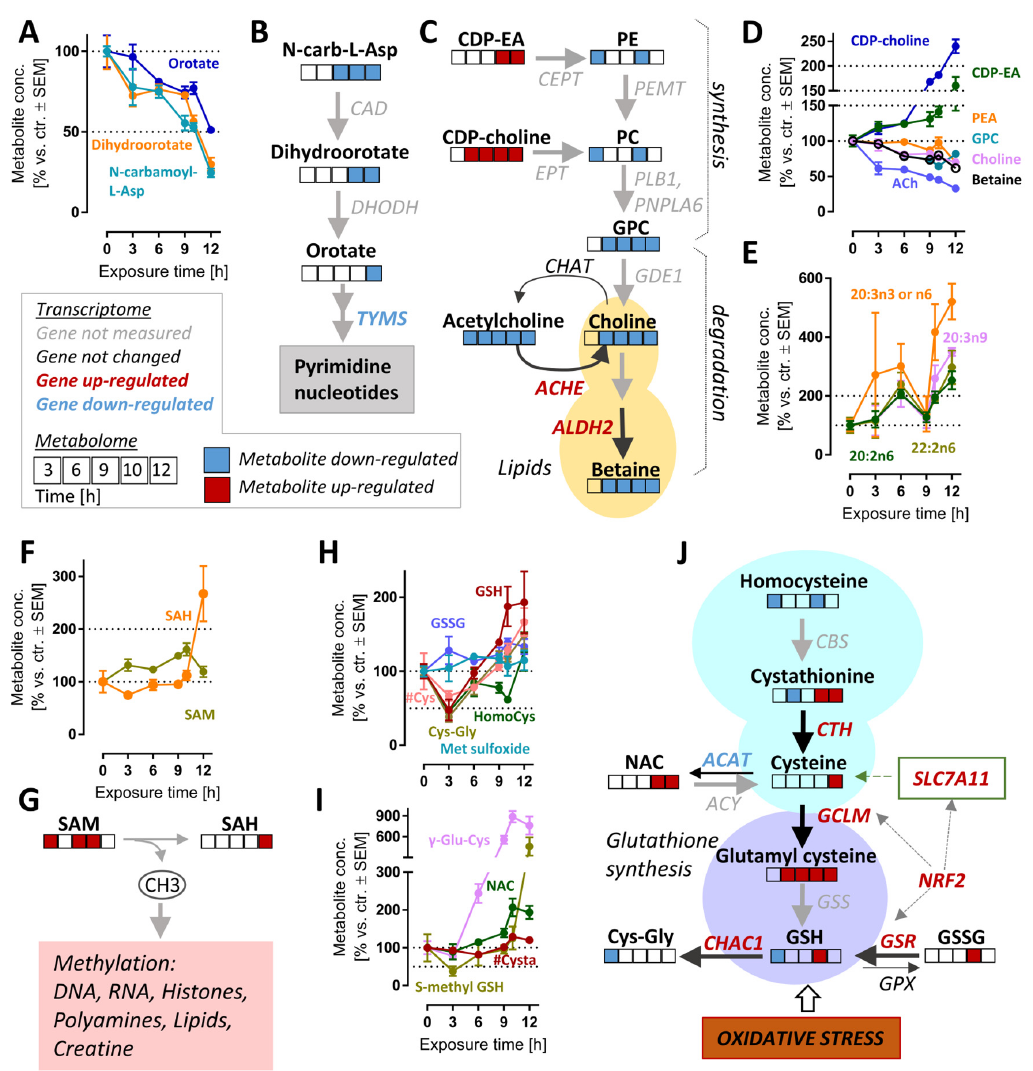
Figure 6. Cell responses relevant to late time points after MG-132 treatment of dopaminergic